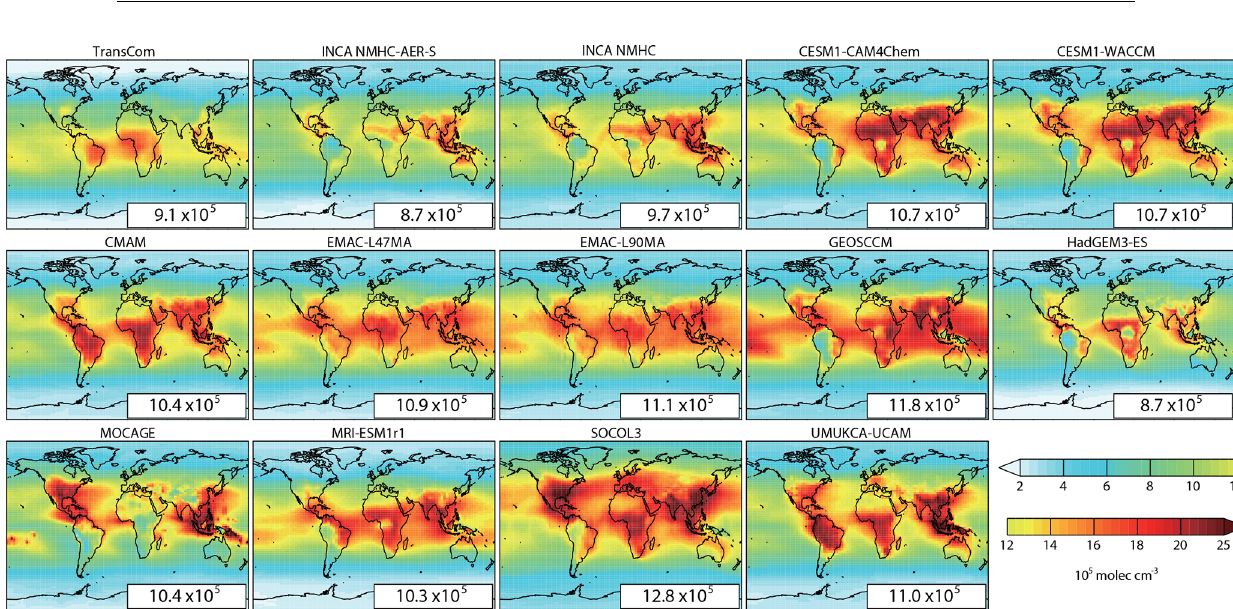
Figure 2. The spatial distributions of volume-weighted tropospheric mean OH fields of the TransCom, INCA, and CCMI models averaged for 2000–2010. Global mean values (10 5 moleccm − 3 ) are shown as